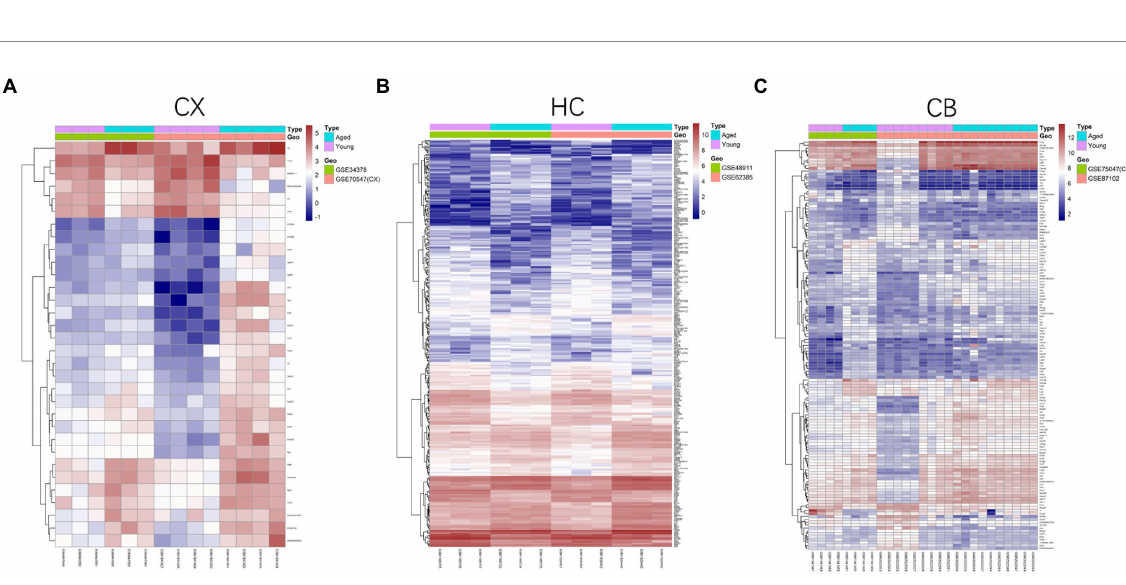
FIGURE 4 Heatmap of DEGs between young and aged groups of CX (A) , HC (B) and CB (C) . The heatmaps were generated using the Pheatmap package. The horizontal axis represents sample symbol and the vertical axis represents gene symbol. The depth of red (high value) and blue (low value) colors represent height of gene expression value. CX, cerebral cortex; HC, hippocampus; CB,